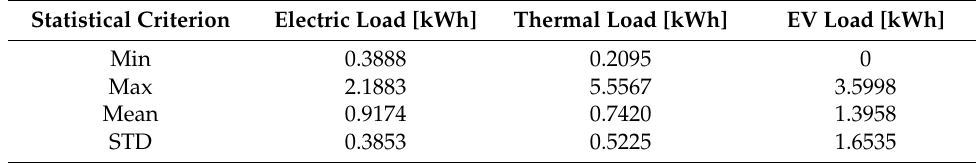
Figure 7. Average daily values of different types of load demand: ( a ) electric load; ( b ) thermal load; ( c ) EV electricity consumption. Table 1. Statistical data of different